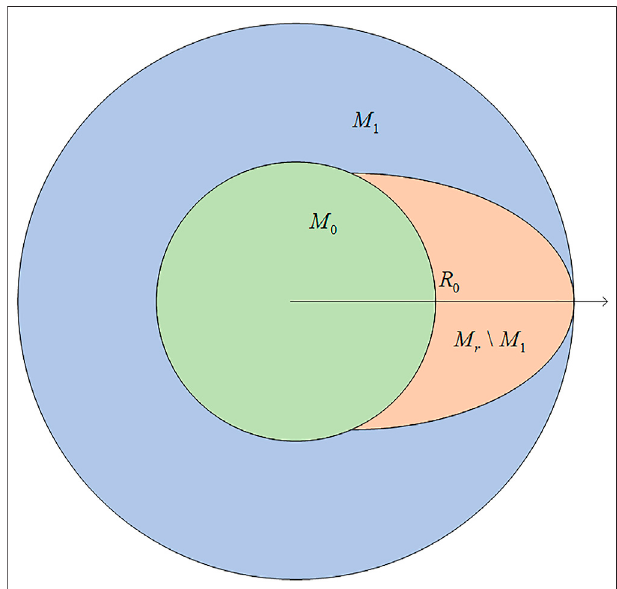
FIGURE 2 | Sheep divided into three parts based on its relative